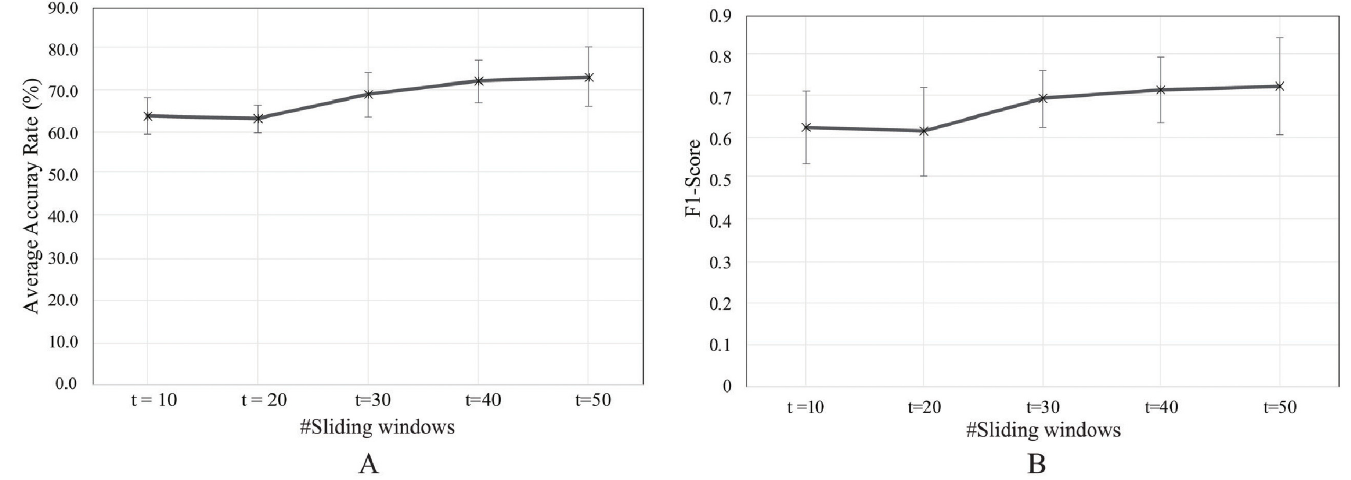
Fig 11. Average accuracy rate of the proposed model in online classification. A: accuracy of the proposed model with a varying number of sliding windows: t = 10 (64.24 ± 4.26%); t = 20 (63.55 ± 3.45%); t = 30 (69.36 ± 5.43%), t = 40 (72.60 ± 5.15%), and t = 50 (73.64 ± 7.15%). B: average F1-score of the proposed model with a varying number of sliding windows: t = 10 (0.63 ± 0.08); t = 20 (0.62 ± 0.10); t = 30 (0.7 ± 0.06%), t = 40 (0.72 ± 0.07%), and t = 50 (0.73 ±